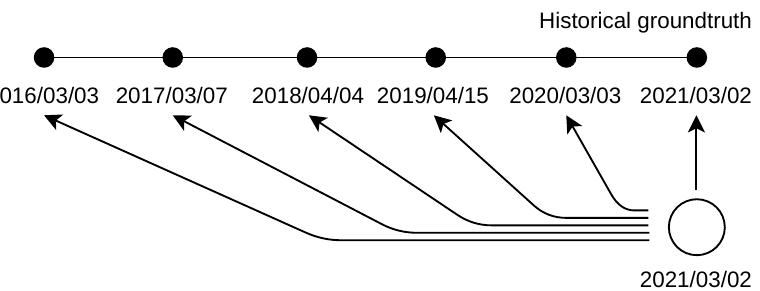
Figure 3. Late IP address location by the most current database. Past IPv4 addresses were dated from 2016. Past IPv6 addresses were dated from 2018.